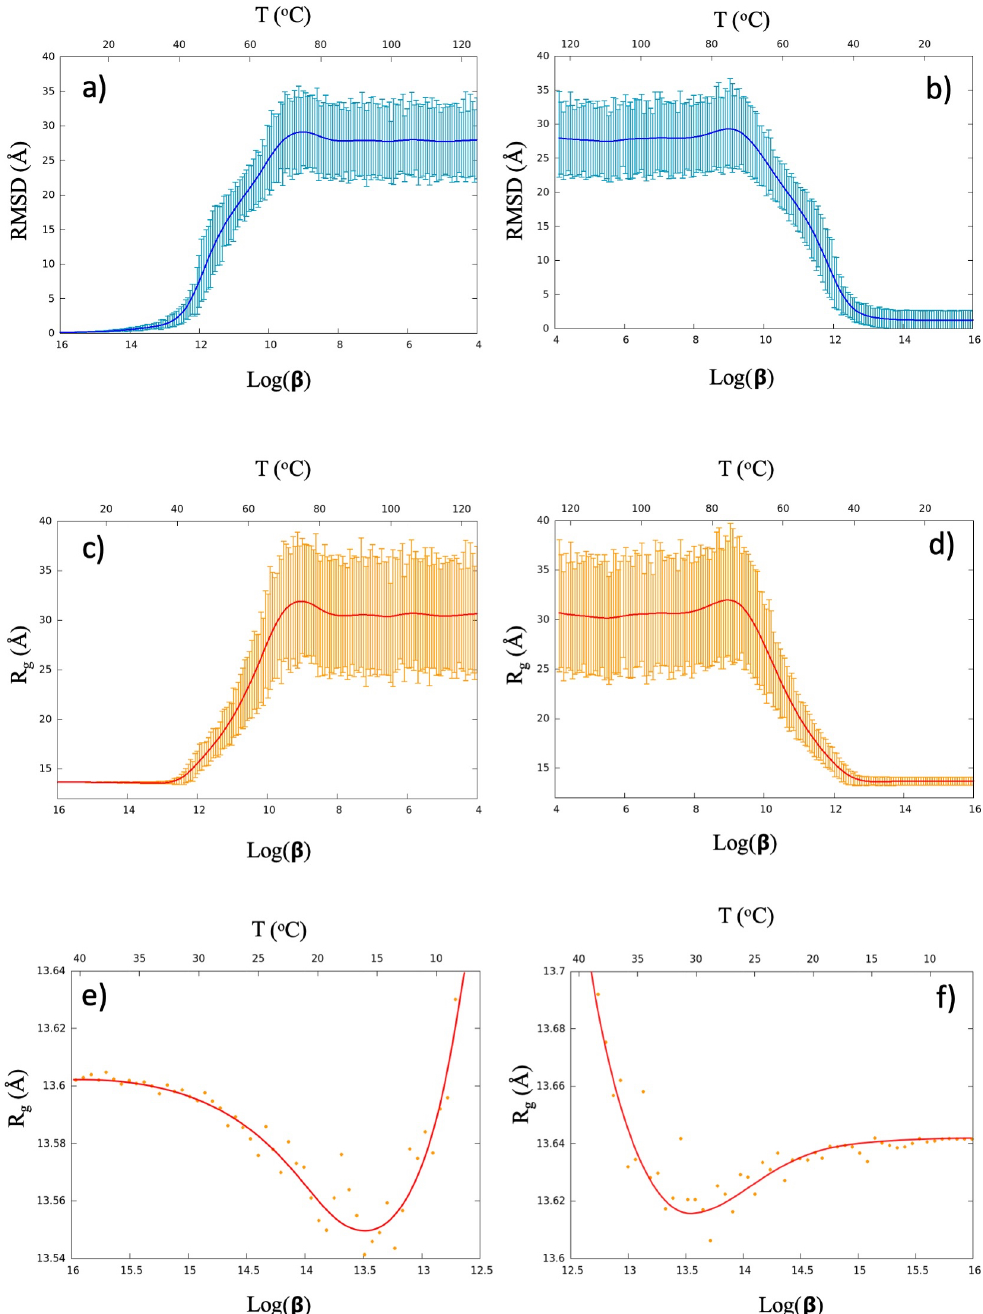
Fig 3. Panel a) shows the evolution of radius of gyration R of the multi-soliton during the heating stage, and Panel b) g shows the R g evolution during the cooling stage. The solid line shows the mean value of the simulation ensemble that consist of 1.000 independent cycles, and the spread denotes one standard deviation. Panel c) and d) show the corresponding results for the root-mean-square distance (RMSD) to the multi-soliton solution. Panels e) and f) are close looks to the R g values, at early/late stages of heating/cooling. There is a clear albeit very slight shrinking at the beginning of the unfolding process, and a similar swelling just before the final slipknot forms. The unfolding always starts from the multi-soliton. But for folding statistics the entire simulation ensemble is included, including those that do not form a slipknot.